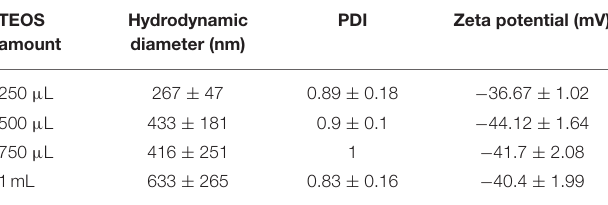
TABLE 2 | Results for the size and ζ potential characterization of AgMSNPs.